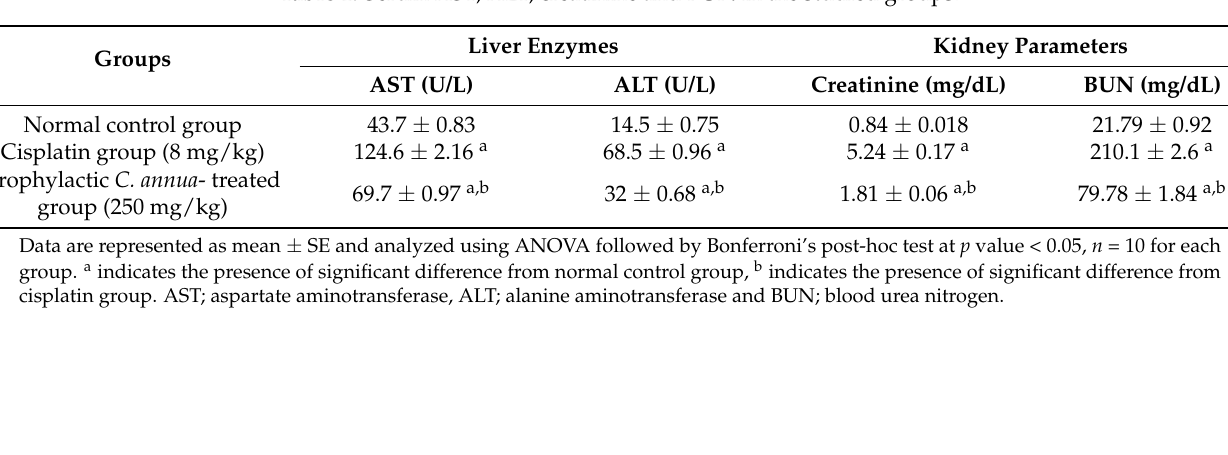
Figure 1. Photomicrographs of H&E- stained sections ( × 400) of liver ( A ) and kidney ( B ) tissues from the experimental groups indicating the protective effects of C. annua pretreatment on cisplatin- induced hepatic & renal toxicities. ( A1 ) liver tissues of normal control group, ( A2 ) liver tissues of Cisplatin group, ( A3 ) liver tissues of Prophylactic C. annua - treated group, ( B1 ) kidney tissues of normal control group, ( B2 ) kidney tissues of Cisplatin group, ( B3 ) kidney tissues of Prophylactic C. annua - treated group. In Figure 1A2 the black arrow indicates portal area congestion, the white arrow represents infiltration of inflammatory cells accompanied by tissue necrosis and the yellow arrow shows the dilatated sinusoid. In Figure 1B2, the black arrow indicates renal tubules hydropic degen- eration and dilatation, the red arrow shows dilatated necrotic tubules, the white arrow represents infiltration of inflammatory cells and the yellow arrow shows glomerular atrophy. Table 1. Serum AST, ALT, creatinine and BUN in the studied